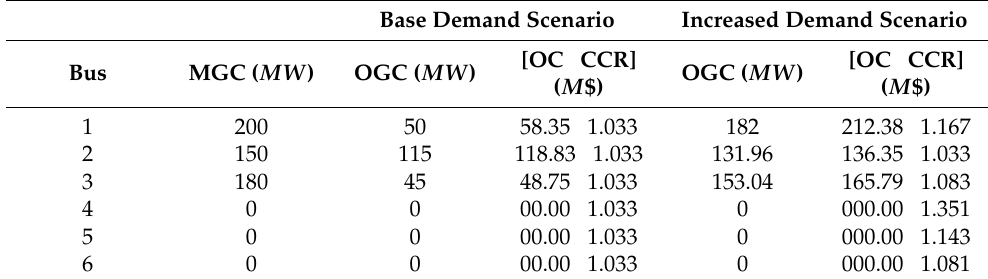
Table 4. Results of the base year—Optimal generation capacity versus optimal generation capacity with demand increase in a 6-bus system.